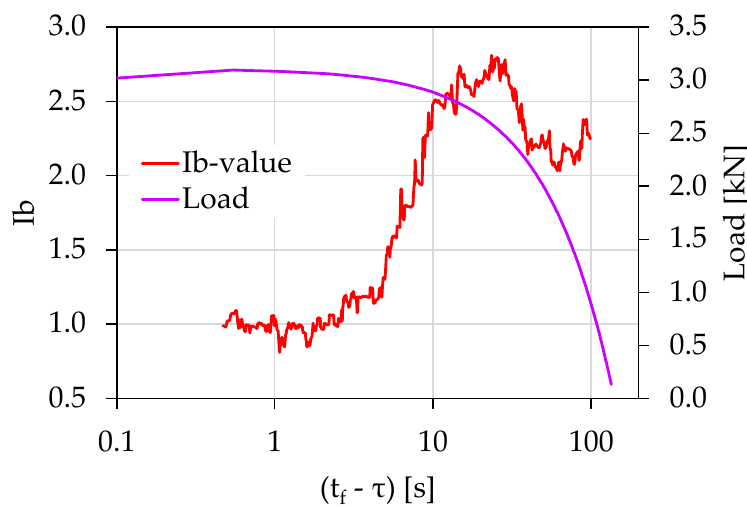
Figure 8. The temporal evolution of the Ib -value in juxtaposition to the load applied for the experiment Exp-LR02 in terms of the “time-to-failure” parameter.